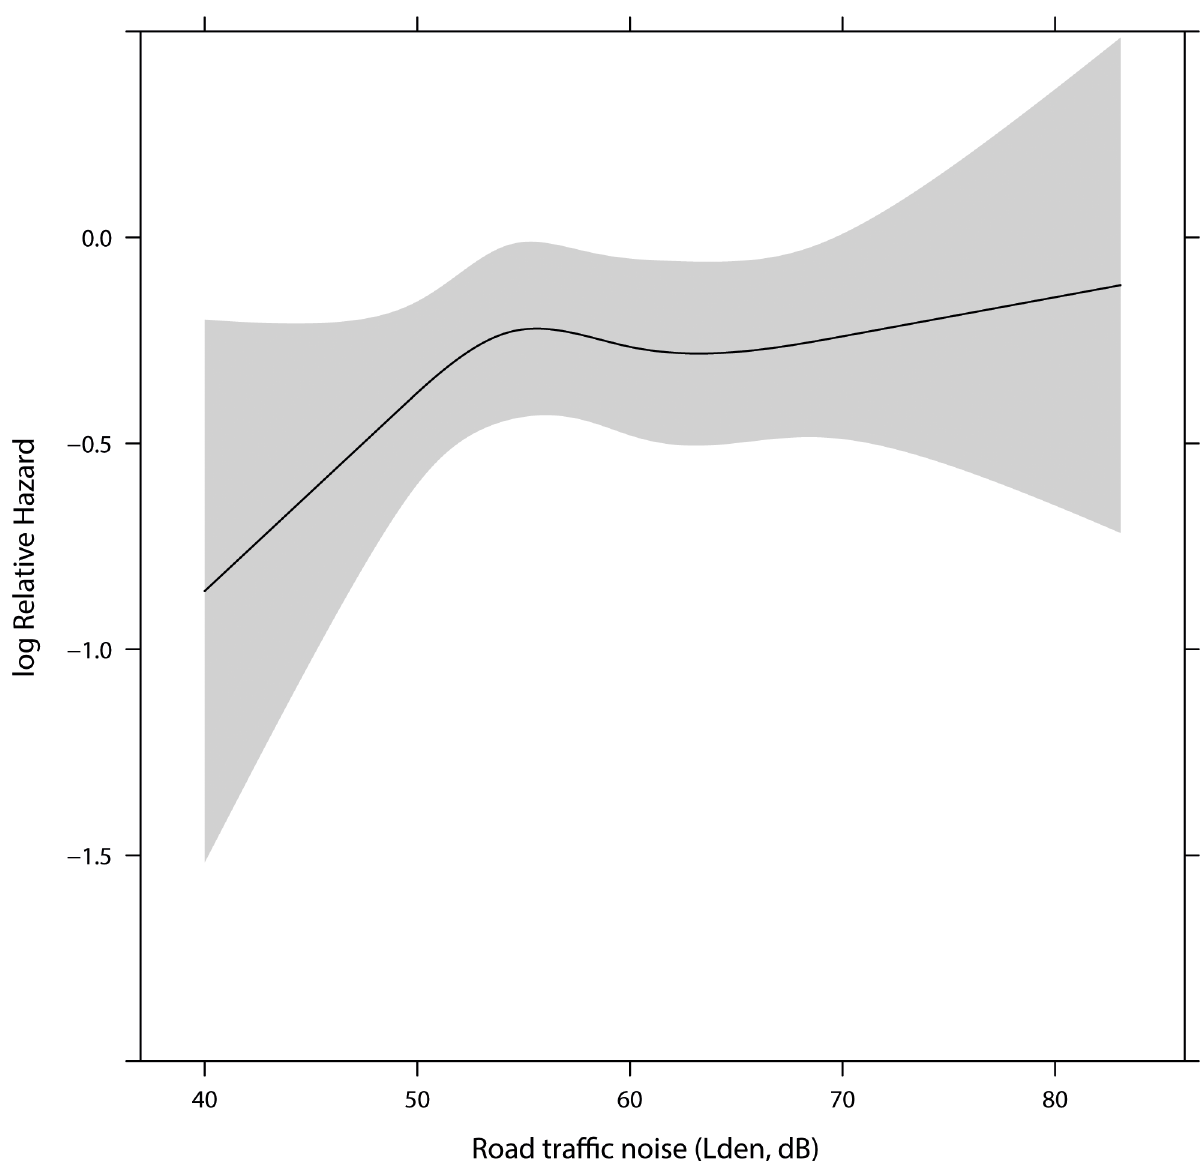
Fig 2. Association between residential exposure to road traffic noise (L den ) and risk for prostate cancer adjusted for smoking status, years of school attendance, area level socioeconomic position, BMI, waist circumference, physical activity, calendar-year and railway noise and airport